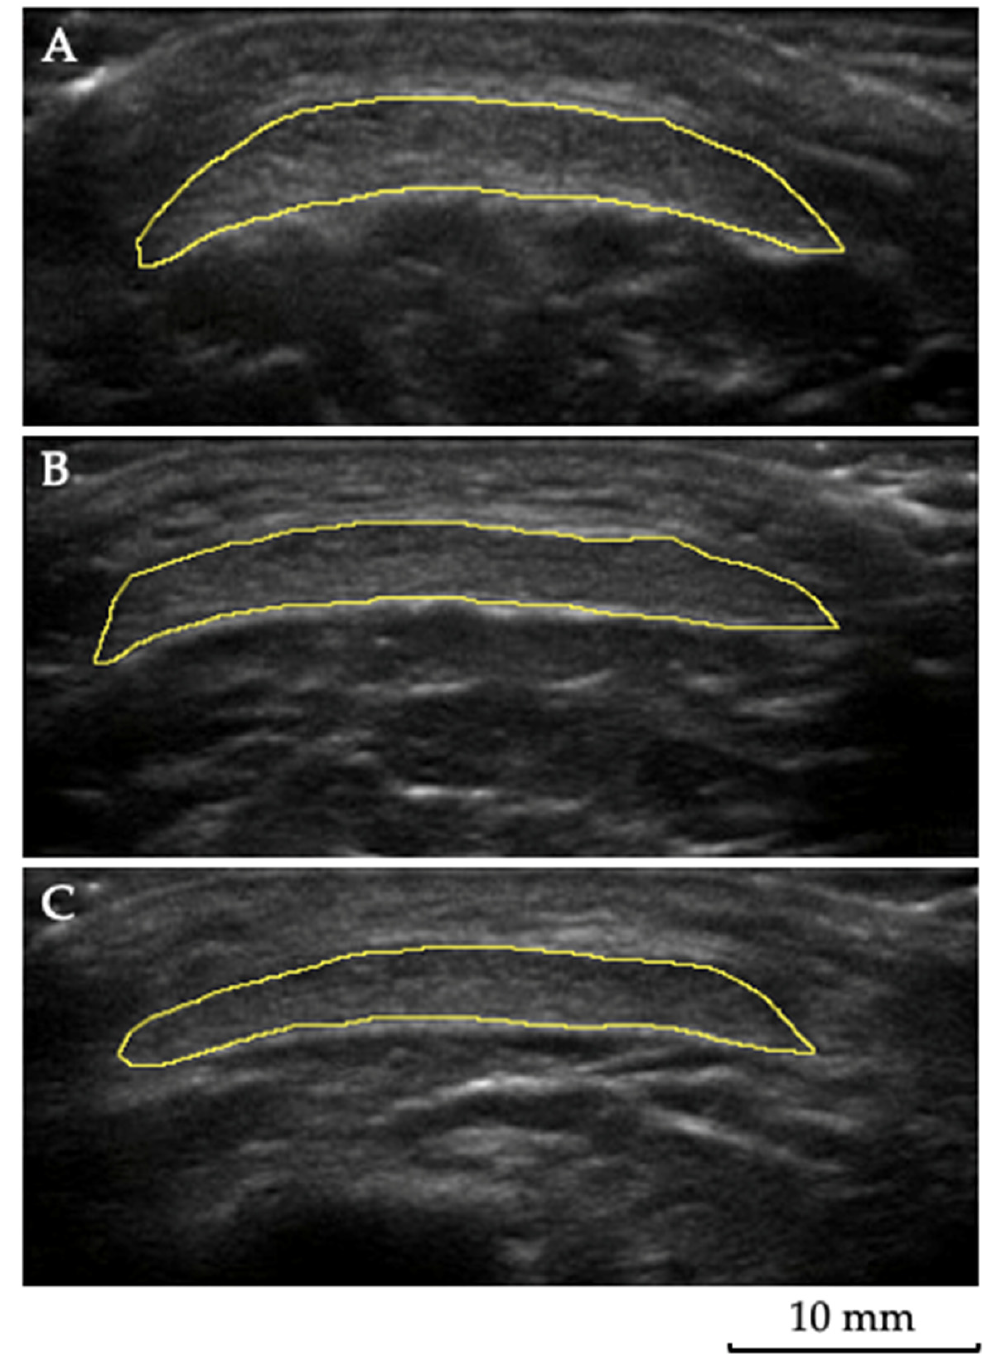
Figure 1. Tendon ultrasonography: a representative image of the patellar tendon ultrasound analysis. For this evaluation, the probe was placed at 25% ( A ), 50% ( B ), and 75%( C ) of the length of the patellar tendon. The tendon contours were selected using the tracing technique to measure the cross-sectional area and echogenicity.